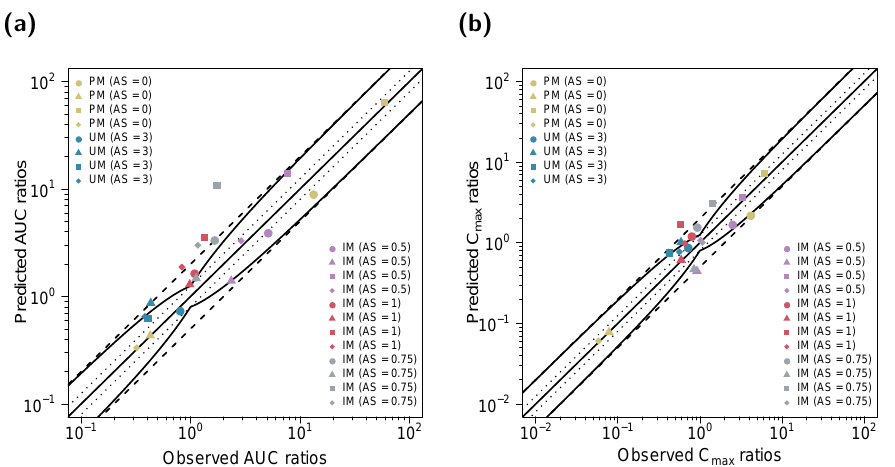
Figure 5. Predicted versus observed DGI ( a ) AUC last and ( b ) C max ratios of ( E )-Clom (circles), ( E )-4-OH-Clom (triangles), ( E )-DE-Clom (squares) and ( E )-4-OH-DE-Clom (diamonds). The straight black lines mark the lines of identity; the curved solid black lines show the limits of the predictive measure proposed by Guest et al. with 1.25-fold variability [32]. Black dotted lines indicate 1.25- fold; black dashed lines indicate two-fold deviation. AS, CYP2D6 activity score; ( E )-4-OH-Clom, ( E )-4-hydroxyclomiphene; ( E )-4-OH-DE-Clom, ( E )-4-hydroxy-N-desethylclomiphene; ( E